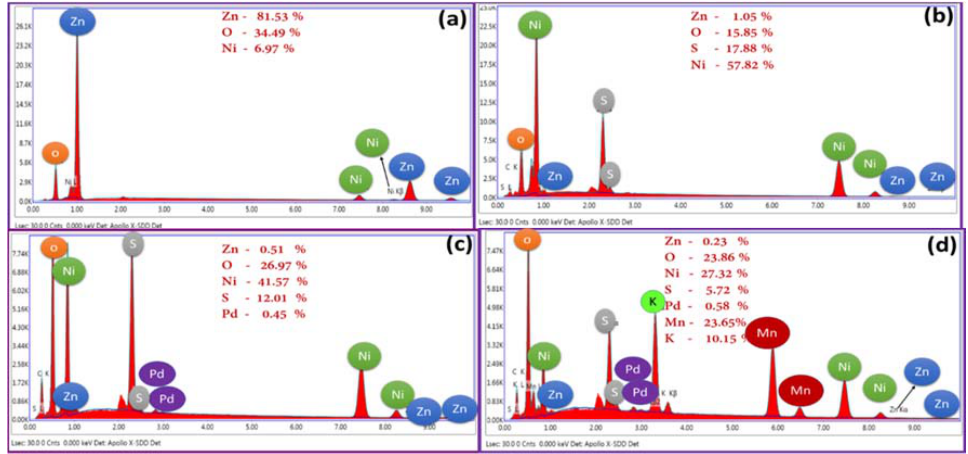
Figure 4. EDX analysis of ( a ) Z, ( b ) ZN, ( c ) ZNP and ( d ) ZNPM.